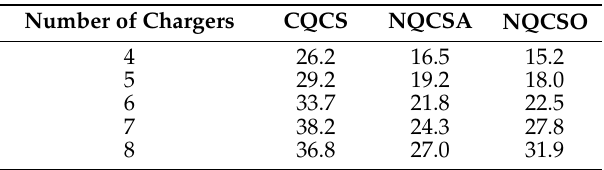
Table 6. Fluctuations of charging load on a CS with different number of chargers during the simulation period in different charging situations (unit: